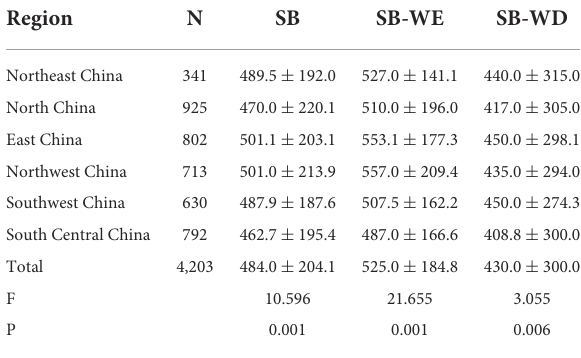
TABLE 4 Comparison of sedentary time among children and adolescents in different regions